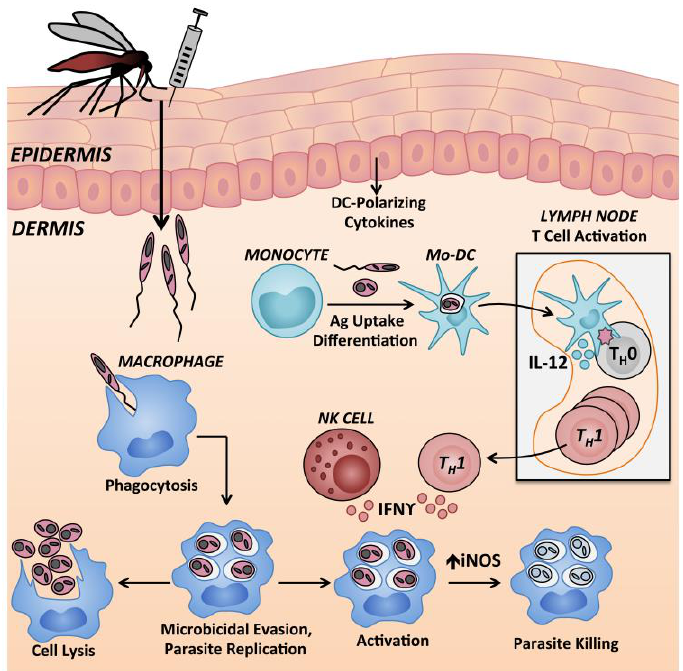
Figure 4. Monocytic cells in control of Leishmania replication in murine skin. Epidermal cytokines can modulate this process. Monocyte derived dendritic cells (Mo-DCs) transport antigen to draining lymph nodes for presentation to naïve CD4 + T cells and resultant T H 1 cells traffic back to the site of infection where they secrete IFN γ . Recruited inflammatory monocytes are the primary host cell allowing intracellular survival and replication of Leishmania spp. Monocytes recruited to the site of intradermal Leishmania inoculation can differentiate locally into dendritic cells or macrophages. Once phagocytosed by macrophages, Leishmania use a variety of virulence mechanisms to suppress the host cell microbicidal response and replicate intracellularly. Infected macrophages can either facilitate intracellular survival and/or replication, or if exposed to activating signals such as IFN γ from T H 1-type cells or NK cells, can upregulate iNOS. The combination of reactive oxygen and reactive nitrogen species can contribute to killing of intracellular parasites. Mo-DC: Monocyte derived dendritic cell; NK cell: Natural killer cell; IFN γ : Interferon γ ; IL-12: Interleukin-12; iNOS: Inducible nitric oxide synthase; T H 1: T helper 1 cell, T H 0: Naïve CD4 + T